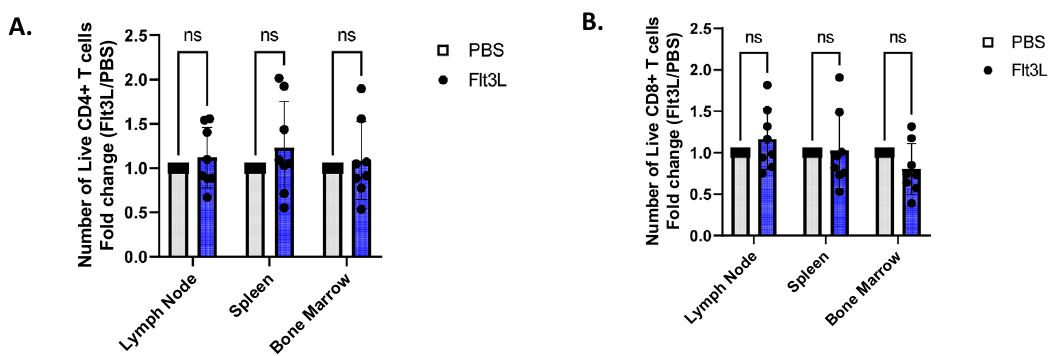
Figure 2. CD4+ and CD8+ T cell numbers remain stable with Flt3L injection. ( A ) Lymph node, spleen, and bone marrow samples were processed and stained to analyze CD4 numbers 1 Day PI. Grey rectangle = control group, Blue = Flt3L-injected group. ( B ) Lymph node, spleen, and bone marrow samples were processed and stained to analyze CD8 numbers 1 Day PI. Grey rectangle = control group, Blue = Flt3L-injected group.